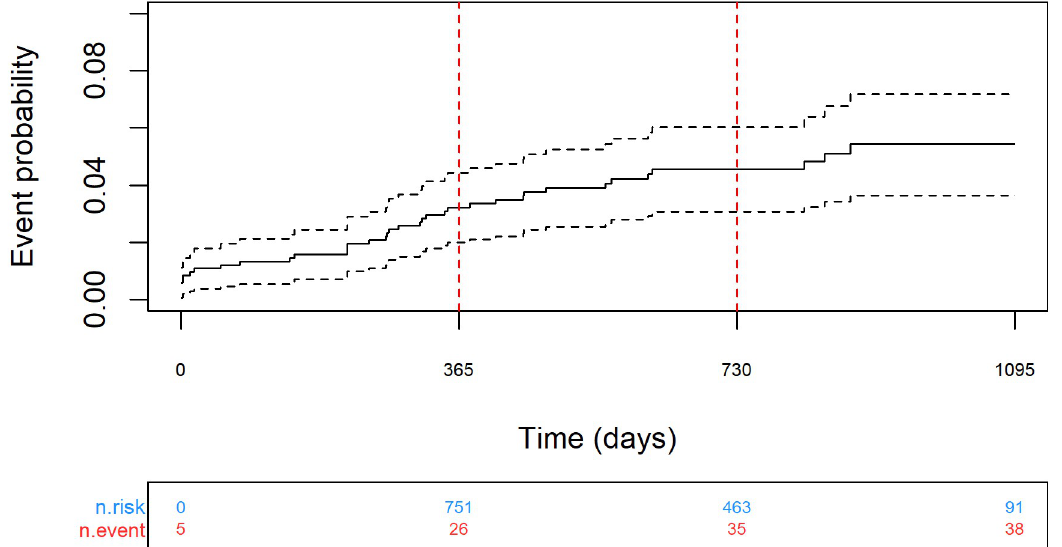
Fig 2. Kaplan-Meier analysis of mortality or neurological event over 2 years’ follow-up (dotted lines show 95% confidence intervals).